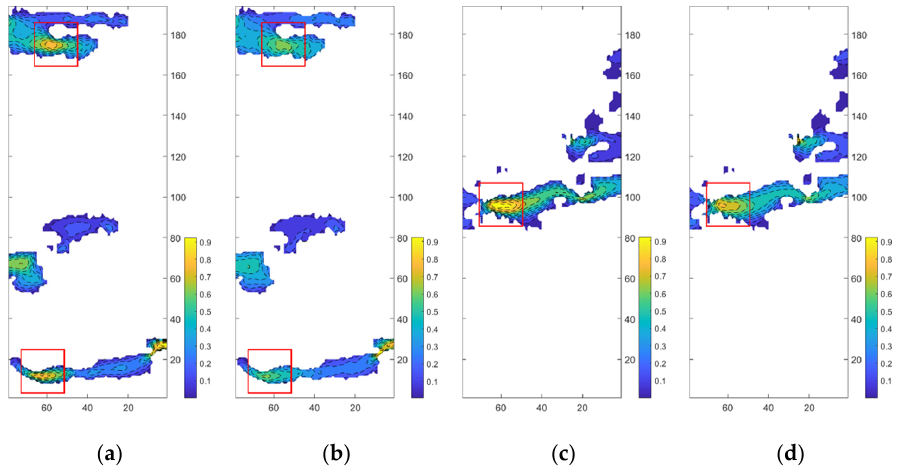
Figure 7. Normalized velocity maps at steady state. ( a ) 𝐾𝑛(cid:3562) = 0.045 at 𝑦 = 41 ; ( b ) 𝐾𝑛(cid:3562) = 5.583 at 𝑦 = 41 ; ( c ) 𝐾𝑛(cid:3562) = 0.045 at 𝑦 = 70 ; and ( d ) 𝐾𝑛(cid:3562) = 5.583 at 𝑦 = 70 .